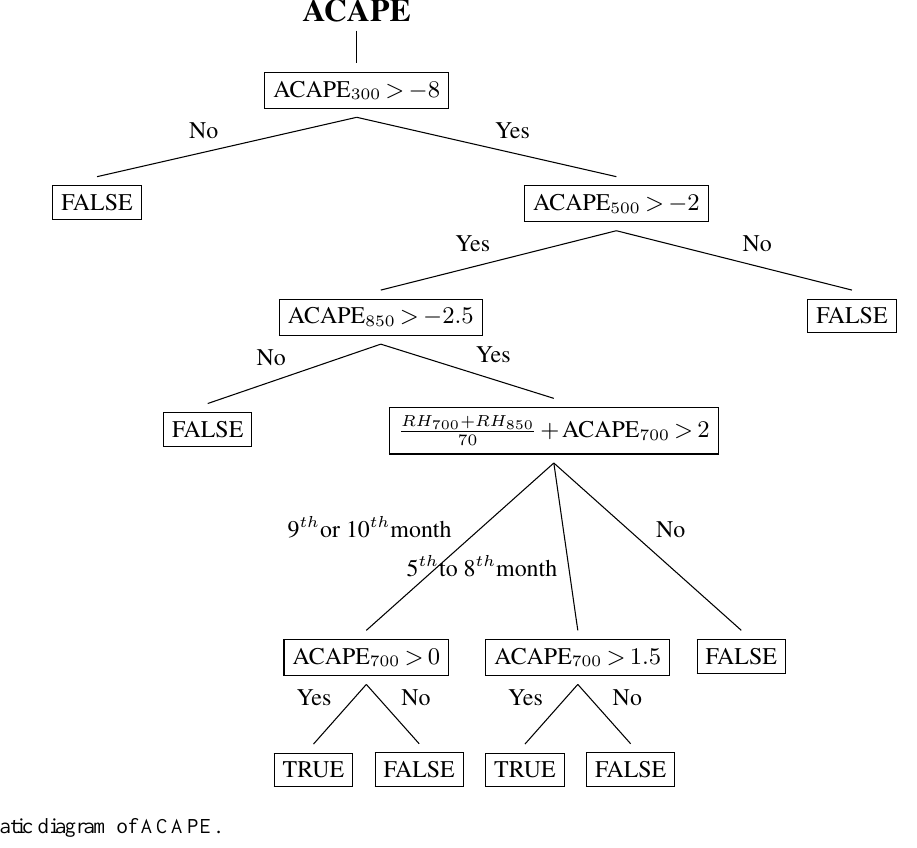
Figure 2. Schematic diagram of ACAPE. Fig. 2. Schematic diagram of ACAPE